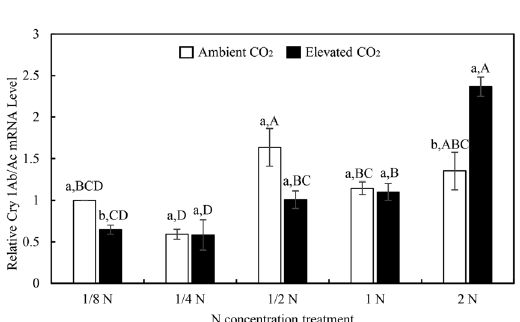
Figure 4. The foliar total soluble protein of transgenic Bt rice grown under ambient and elevated CO 2 with different N-fertilizer augmentation rates. Different lowercase and uppercase letters indicate significant differences between the ambient CO 2 and elevated CO 2 within N-fertilizer rate, and between the different N-fertilizer rates within CO 2 level by LSD test at P < 0.05.